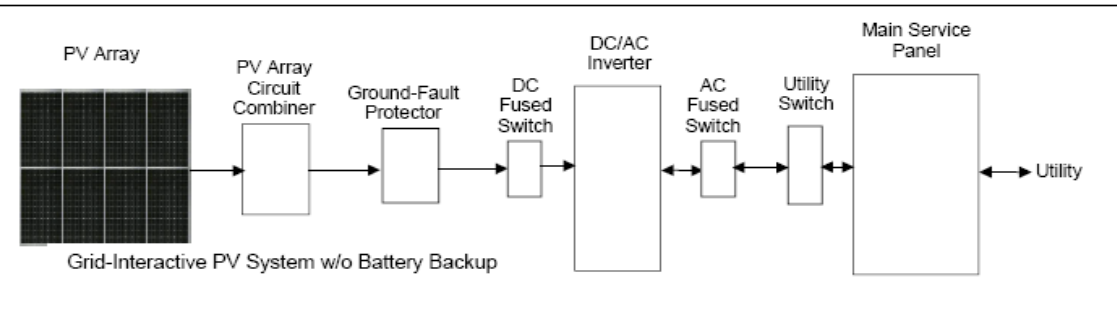
Figure 1. A diagram of a PV system